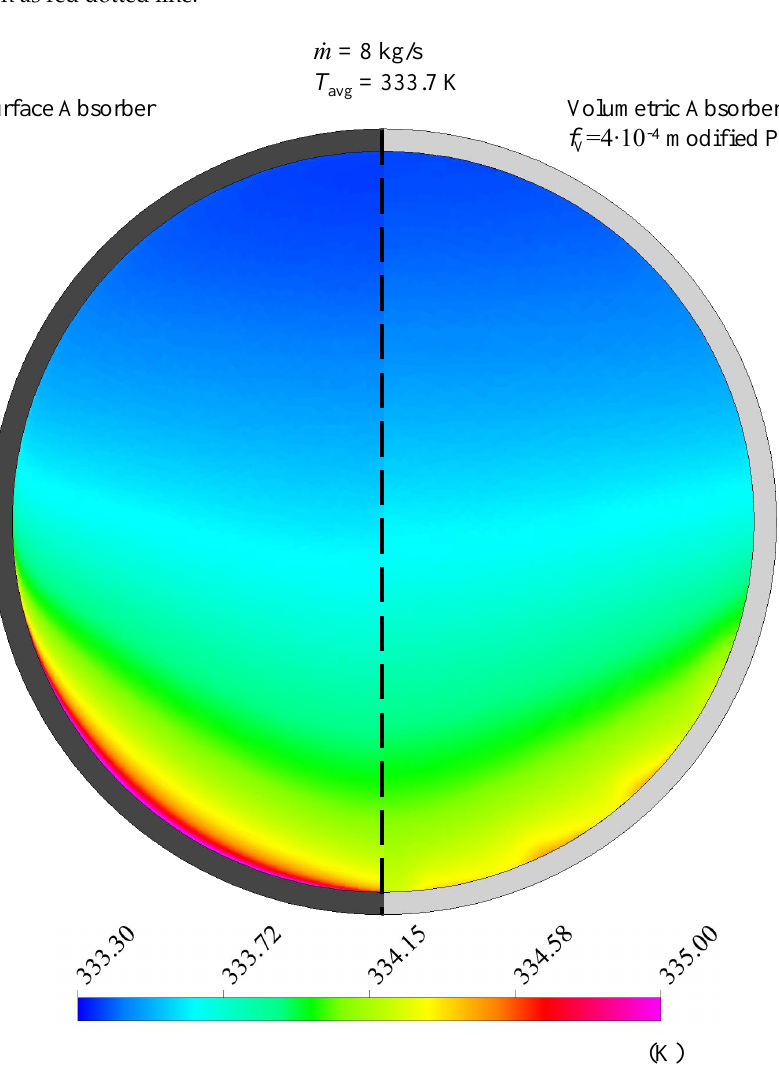
Figure 7. At the same average temperature of T avg = 335.29 K, the temperature distribution is less homogeneous in the surface absorber (left) than in the volumetric absorber